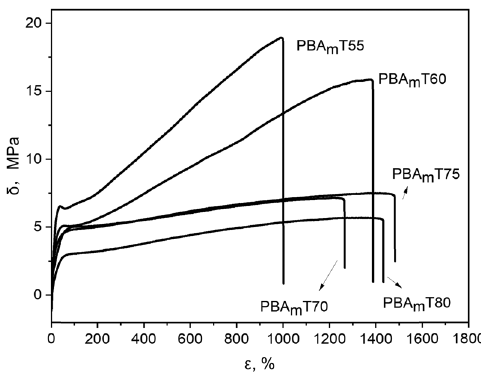
Figure 4: Stress ( σ ) – strain ( ε ) curves of PBA m T.